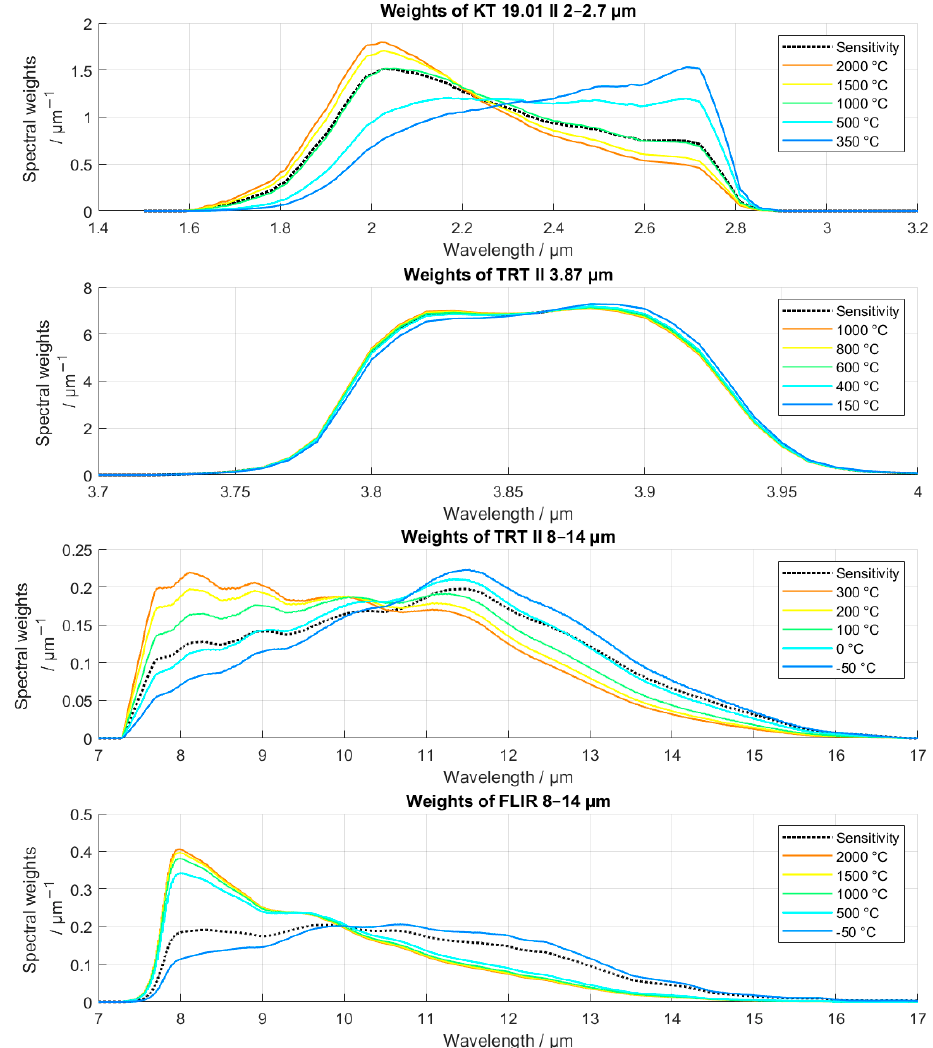
Figure 13. Spectral weights for averaging of the spectral emissivity for different sensors. Spectral weights were calculated according to Equation (29) using spectral sensitivities from Figure 5 and black body emission according to Equation (1). Note that with the spectral shift of the peak of the spectral radiance to the wavelengths outside the sensitivity range of the sensor, the instrumental emissivity spectral representation is less sensitive to temperature variations.